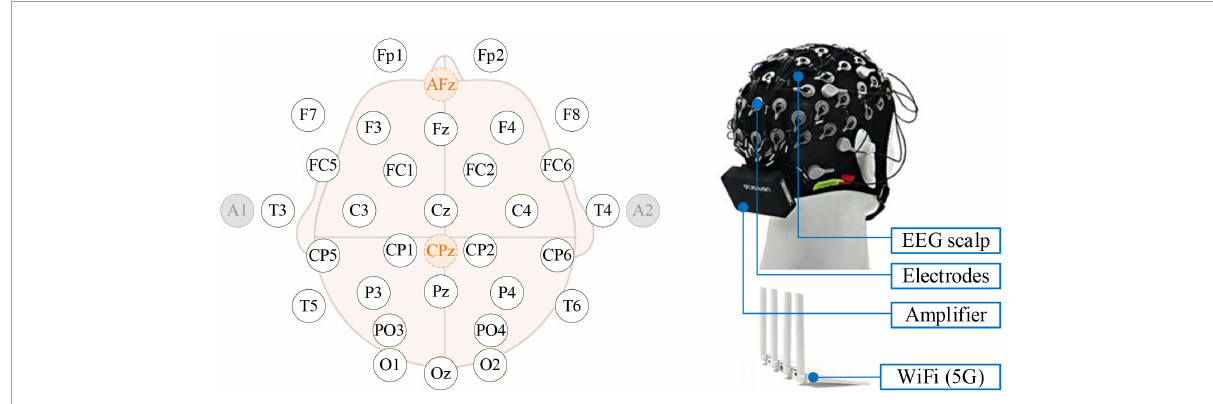
FIGURE1 The Neuracle device and its electrode placement. By system default, the Afz is the ground, CPz is the reference, and A1 and A2 are EOGs.